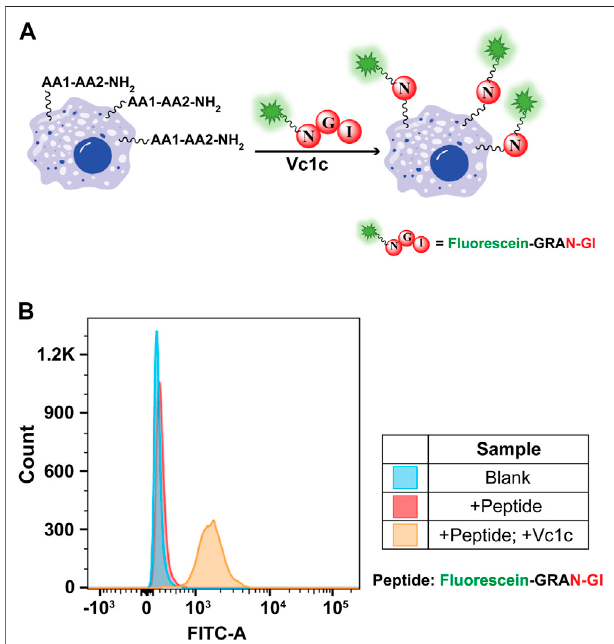
FIGURE7| Vc1c-mediated MCF-7celllabelling. (A) Schematic ofMCF- 7 cell surface amine labelling with the peptide fl uorescein-GRANGI using Vc1c. (B) Flow cytometry analysis of MCF-7 labelling with the peptide fl uorescein-GRANGI. Untreated cells with neither peptide nor ligase added and cells with only peptide added were used as negative controls. The reaction was conducted at 37 ° C for 1 h using 50 μ M fl uorescein-peptide and 200 nM